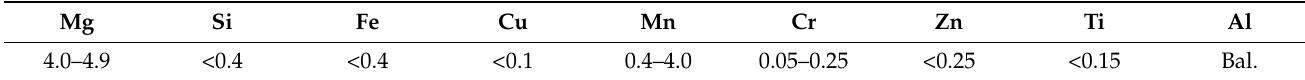
Table 1. Chemical composition of AA5083 (mass %).